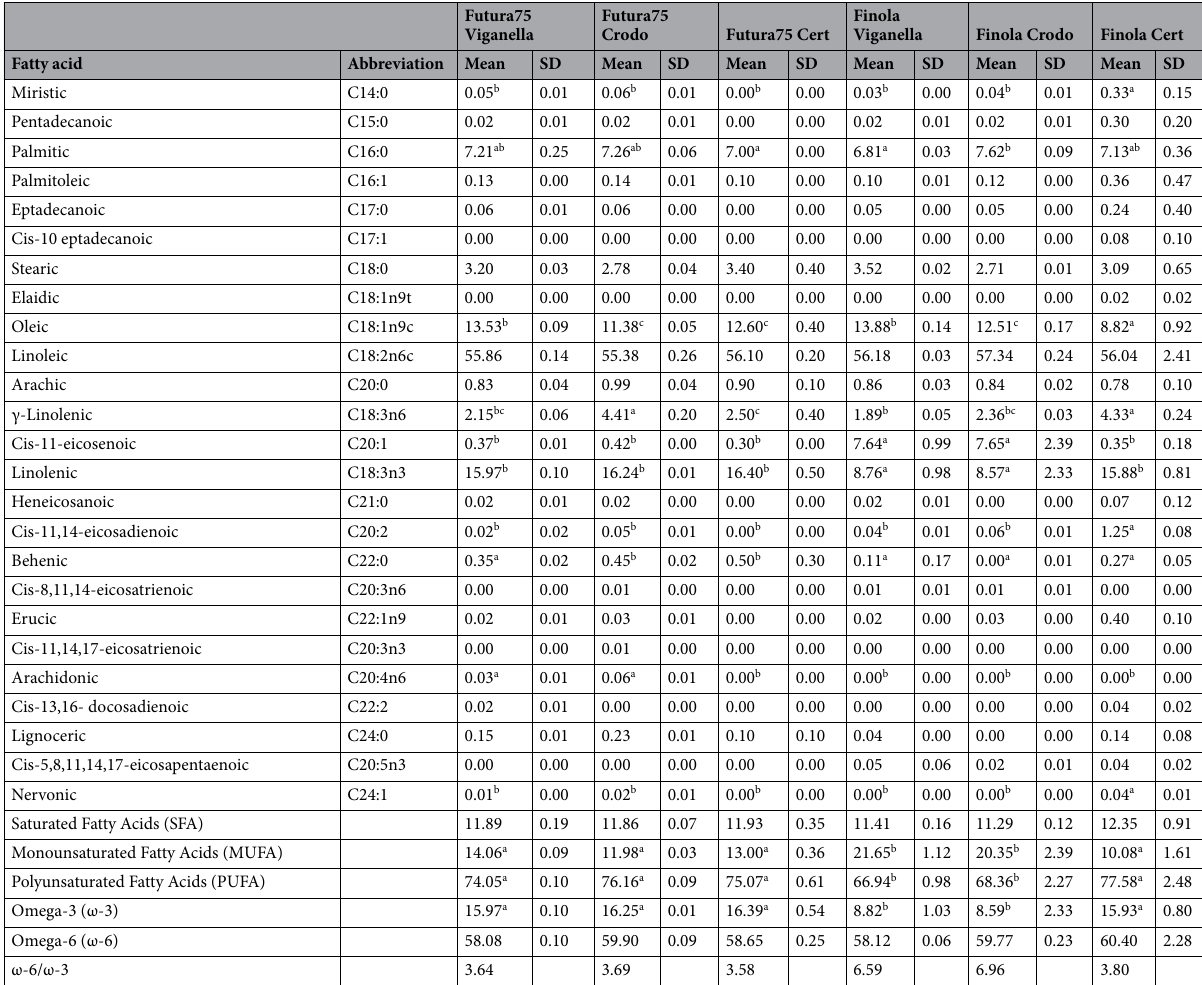
Table 2. Fatty acid profile and composition (w/w%) in Finola and Futura 75 seeds. Fatty acid contents are expressed as means ± SD (n = 3, independent biological replicates). Significant different values (P < 0.05, Tukey post-hoc test, Bonferroni adjustment) are indicated by different